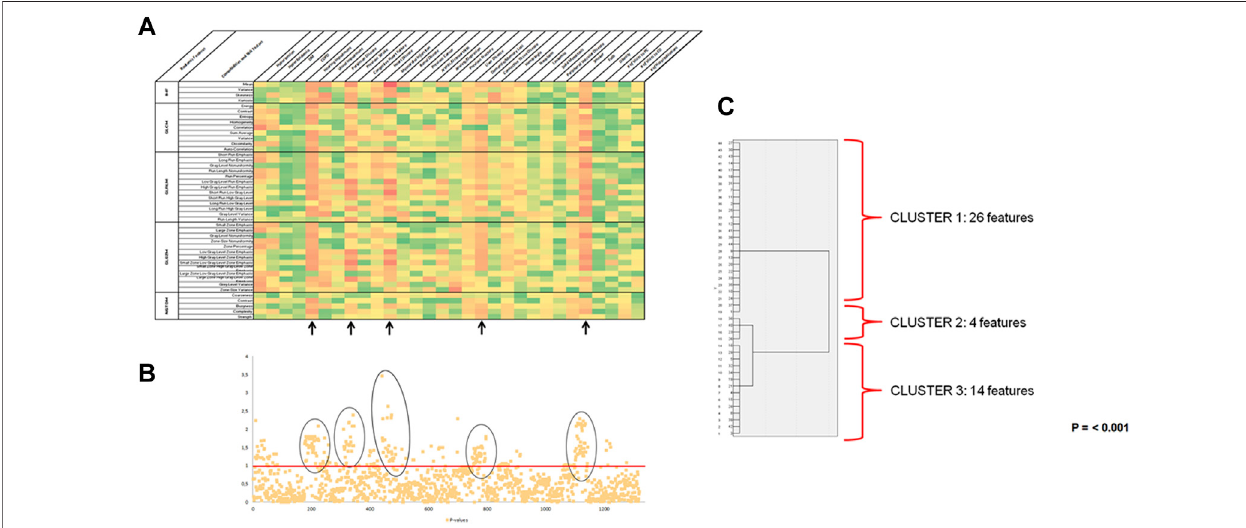
FIGURE 2 | Prognostic value of radiomic data. (A) Heatmap of Rho of Spearman Correlation coef fi cients for an association of Radiomic Features and Incidence of new diseases and riskfactors ( n = 101). On the x -axis, radiomics featuresareshown, and on the y -axis arethe incidence ofcomorbidities and risk factors. The elements of the heatmap are color-coded depending on the value of the correlation coef fi cient. Red is for the highest value and green for the lowest, with 5 different colors in between. Abbreviations: DM: Diabetes Mellitus; COPD: Chronic Obstructive Pulmonary Disease; #: number; PC: primary care; ED: emergency department; IHF: Intensity Histogram Features; GLCM: Gray-Level Co-occurrence Matrix; GLRLM: Gray-Level run-Length Matrix; GLSZM: Gray-Level Size Zone Matrix; NGTDM: NeighborhoodGray-ToneDifferenceMatrix.Note.TauBofKendalwasusedforthestatisticalanalysis. (B) Manhattanplotof p -valuesforassociationsbetweenradiomic features and incidence of new diseases and risk factors ( n = 101). p -values for univariate associations between each radiomic feature and the incidence of new disease and risk factors after 2 years of following from baseline ultrasound. Radiomic features are situated on the x -axis in the same order as the heatmap, while the corresponding p -valuesare located on the y -axis and graph with a-LOG10 ( p -value) scale. Pointsabove the red line ( p = < 0.05) indicate radiomic featuresin which case the incidence of new diseases or risk factors showed signi fi cant association. (C) Hierarchical cluster dendrogram ( n = 44). Hierarchical cluster dendrogram of radiomic features signi fi cantly associated with hearing impairment, stroke, myocardial infarction, dementia or memory loss, and falls. Three independent clusters are identi fi ed for the radiomic phenotype ( p = 0.001).